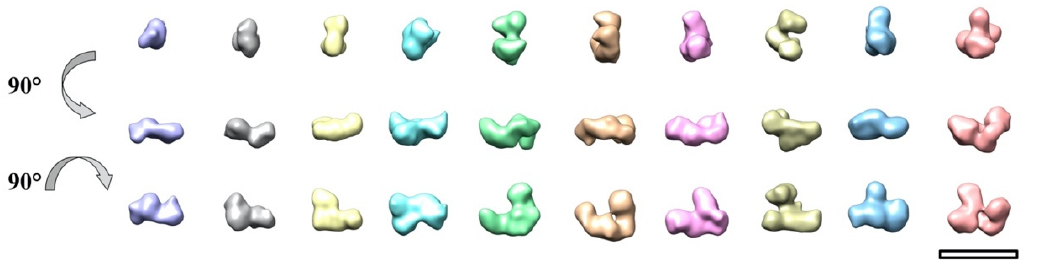
Figure A4. Various projections of iron clusters with a volume in the range 4–10 nm 3 at a threshold of 3 σ divided into 10 3D classes. The classes are arranged in ascending volume (left to right). Scale bar is 5 nm.